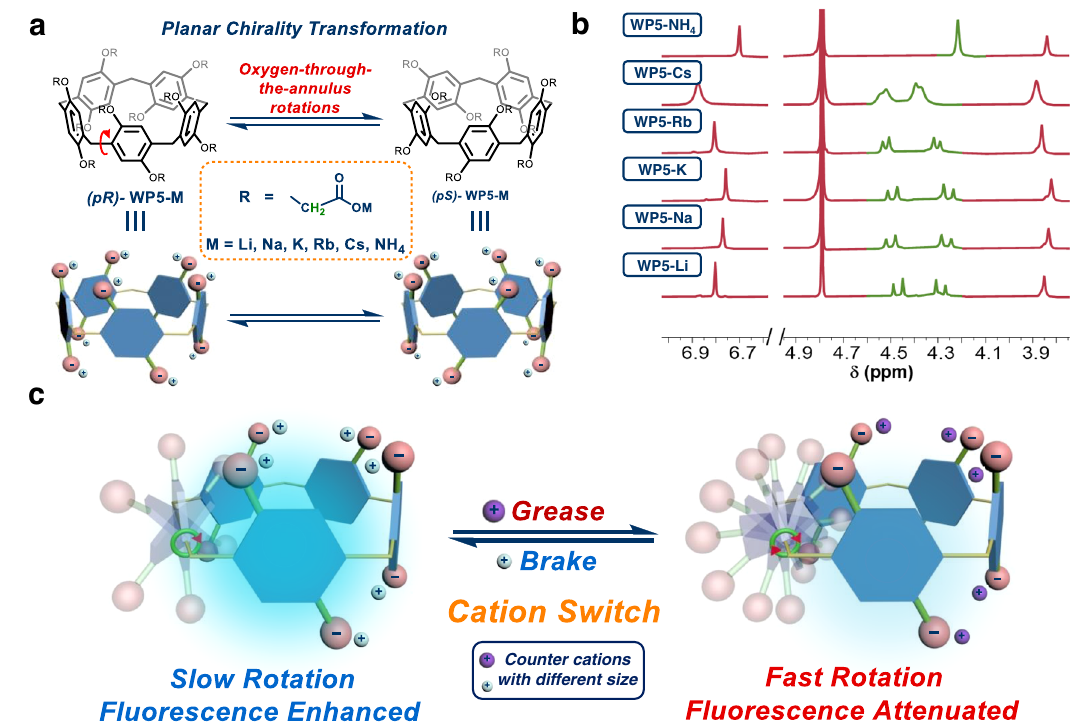
c Cartoon Illustrations of cation-modulated switchable rotary motion of WP5-M (silver and purple balls represent different counter cations with distinct size). For simpli fi cation, only one rotary phenolic ring of WP5 is